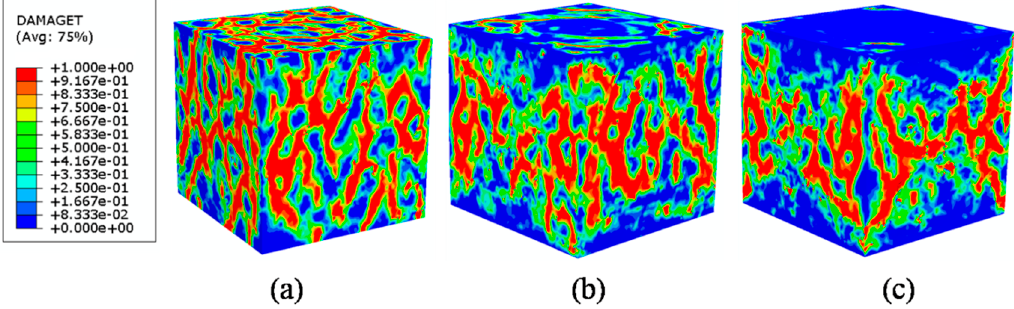
Figure 22. Failure patterns of different frictional coefficients µ : ( a ) µ = 0.1, ( b ) µ = 0.3, ( c ) µ = 0.6.